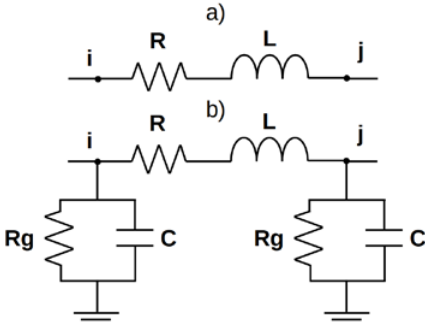
Fig. 4. Equivalent circuits for a) transformers and autotransformers, b) power transmission lines .